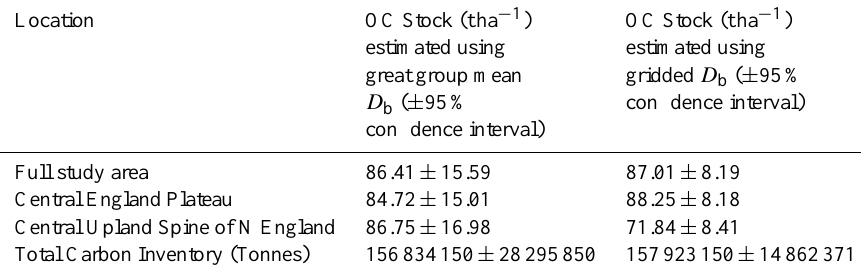
Table 4. Carbon stock for the entire study area and by selected